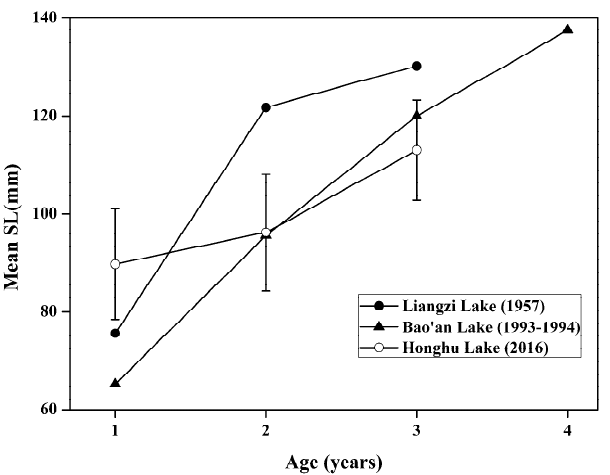
Figure 3. Estimated mean standard length (SL)-at-age of the studied modern-day population (Honghu Lake) and two historical populations (Bao’an Lake and Liangzi Lake) of Odontobutis sinensis in the middle Yangtze River, China.